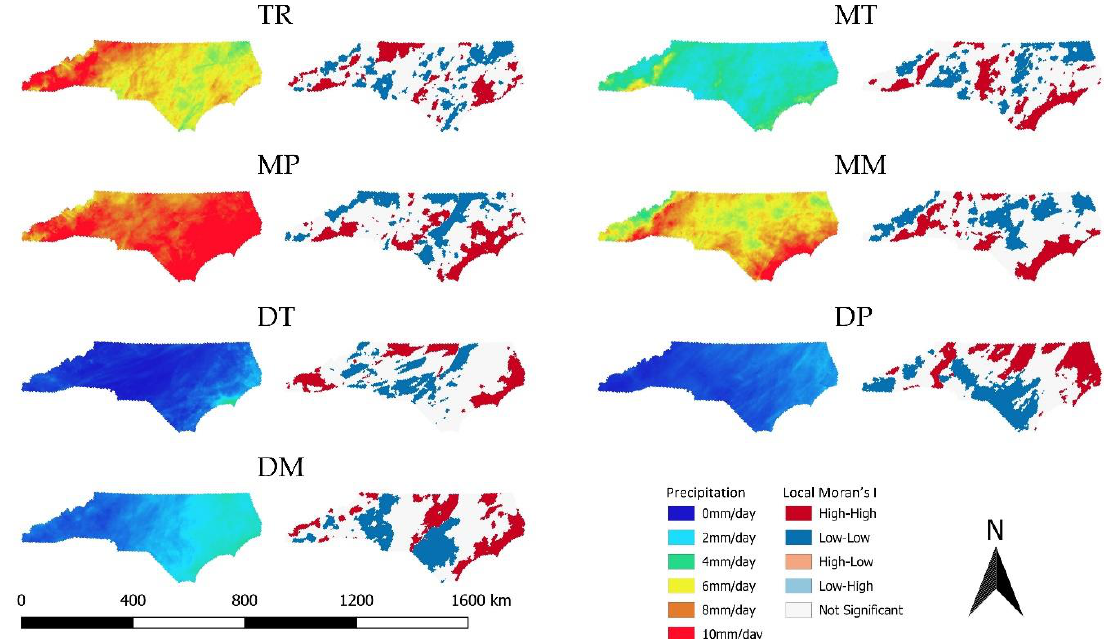
Figure 11. Fall (SON) daily average precipitation ( left ) and spatial clustering analysis of precipitation Figure 11. Same as Figure 5 but for fall (SON). ( right ) for each SSC air mass